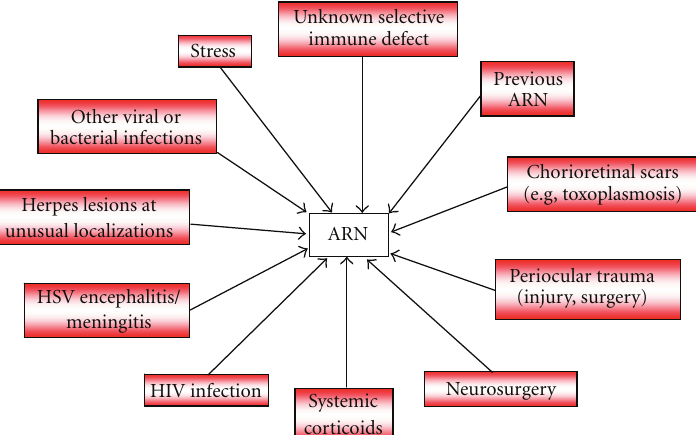
Figure 3: Risk factor model for the reactivation of latent herpes simplex (HSV) or varicella zoster virus infections leading to acute retinal necrosis